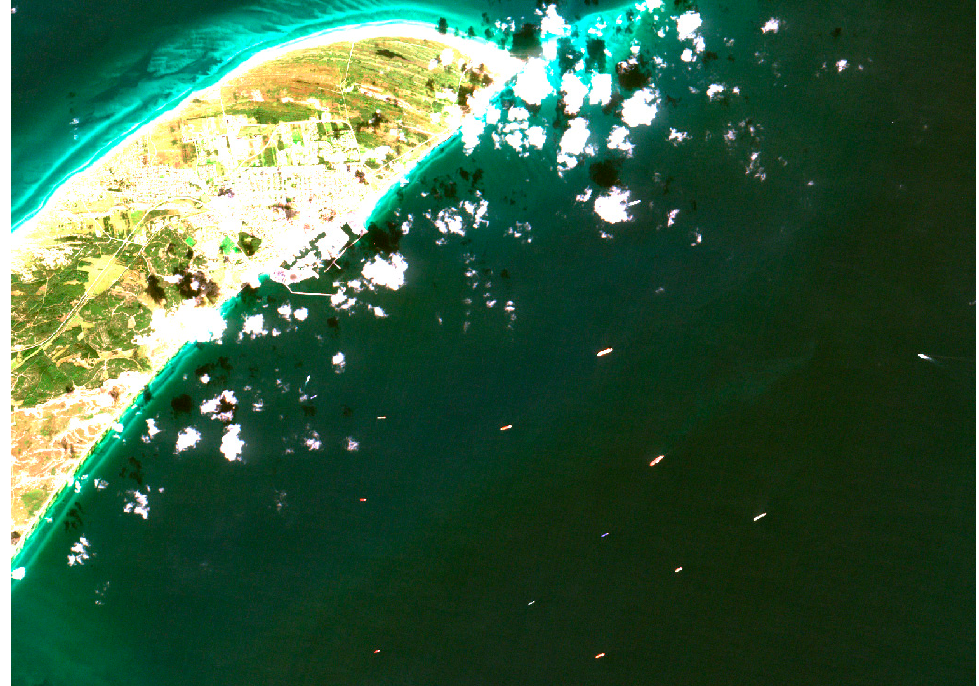
Figure 1. Sentinel-2A image tile VNK from 23 August 2016 at 10:30 a.m. UTC showing Skagen—the northernmost tip of Denmark. The image is RGB contrast-enhanced. A number of container and tanker ships (see Table 1) are moored just east of Skagen in the tranquil sea of Kattegat, a number of which are waiting for bulk fuel. Close to the coast a few clouds can be seen, with their shadows being cast northward.